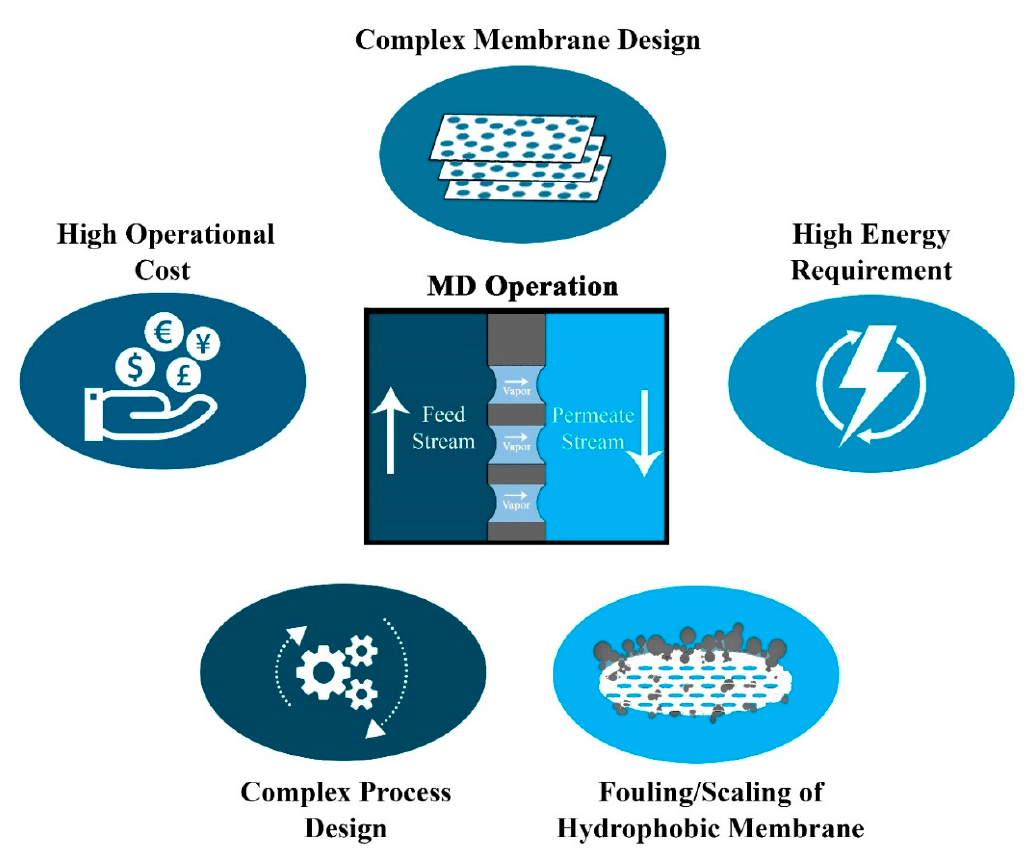
Figure 1. Challenges of an ideal membrane distillation (MD) process in the field of water treatment and desalination.